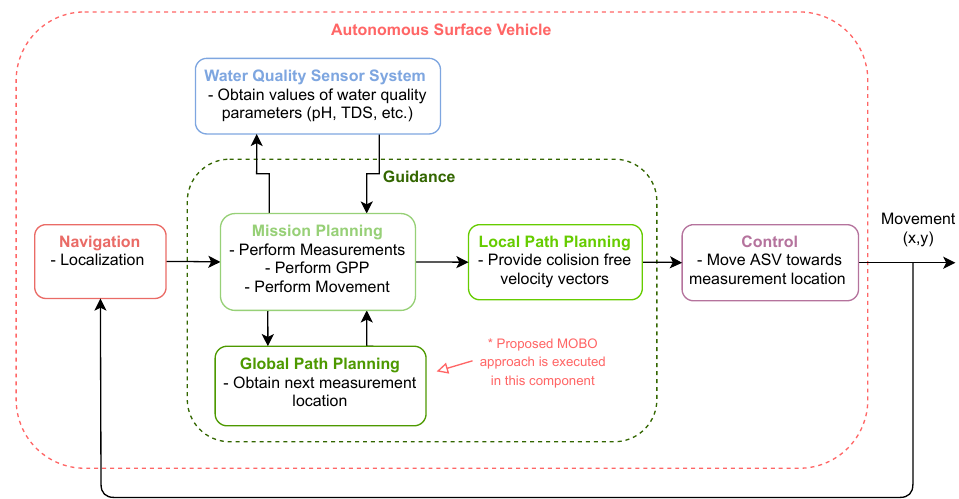
Figure 3. General systems of the designed ASV. Consists mainly on 4 subsystems: water quality sensors, navigation, guidance, and